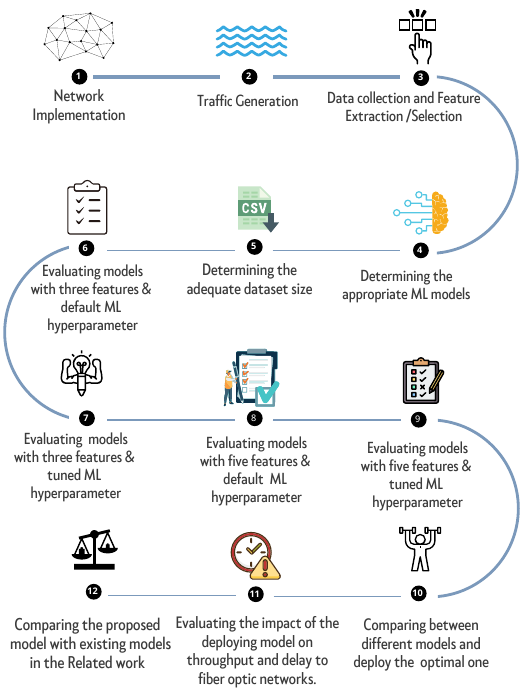
Figure 5. Research